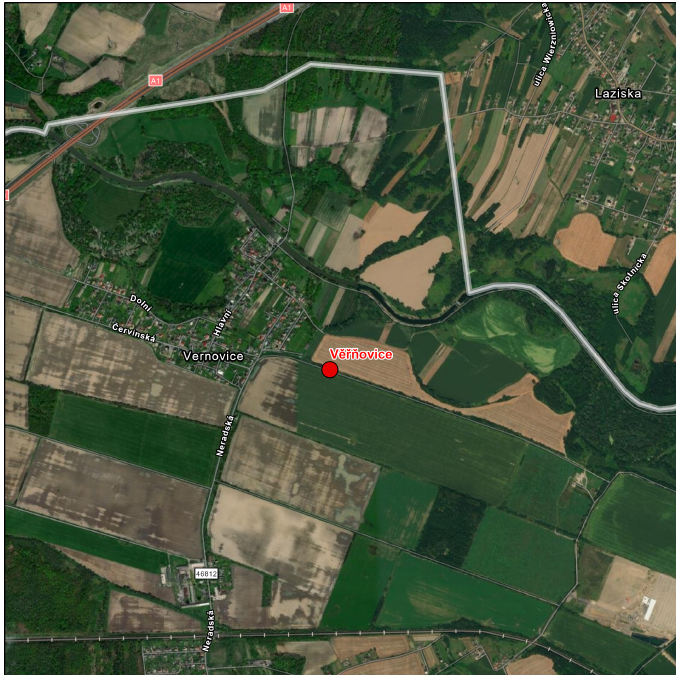
Figure A5. Location of the Vˇeˇrˇnovice station.